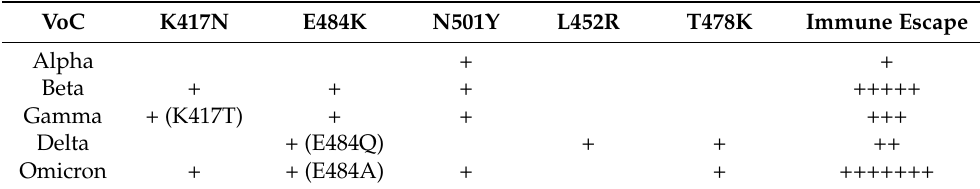
Table 2. The most significant mutations providing immune escape of VoC strains. Number of pluses reveal the strength of the immune